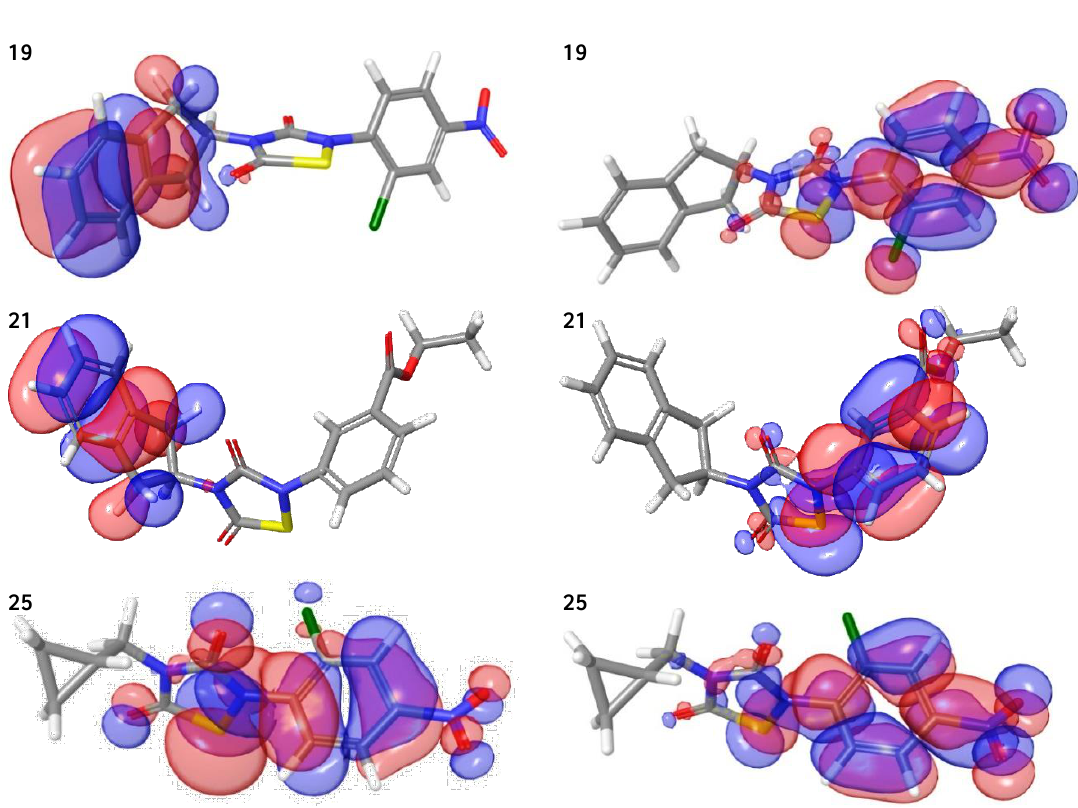
Figure S5. The orbital density distributions of compounds 19 , 21 and 25